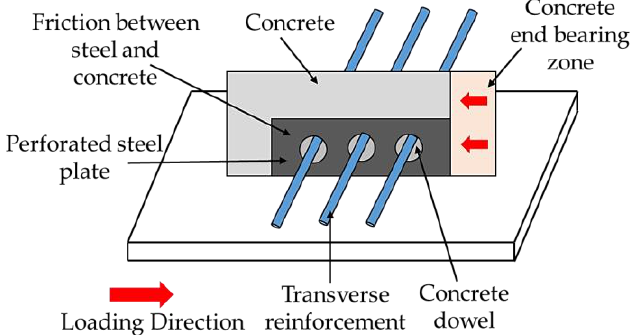
Figure 1. Representation of force-resisting components of a typical perfobond rib shear connector [Perfobond Leiste in German (PBL)] shear connector.